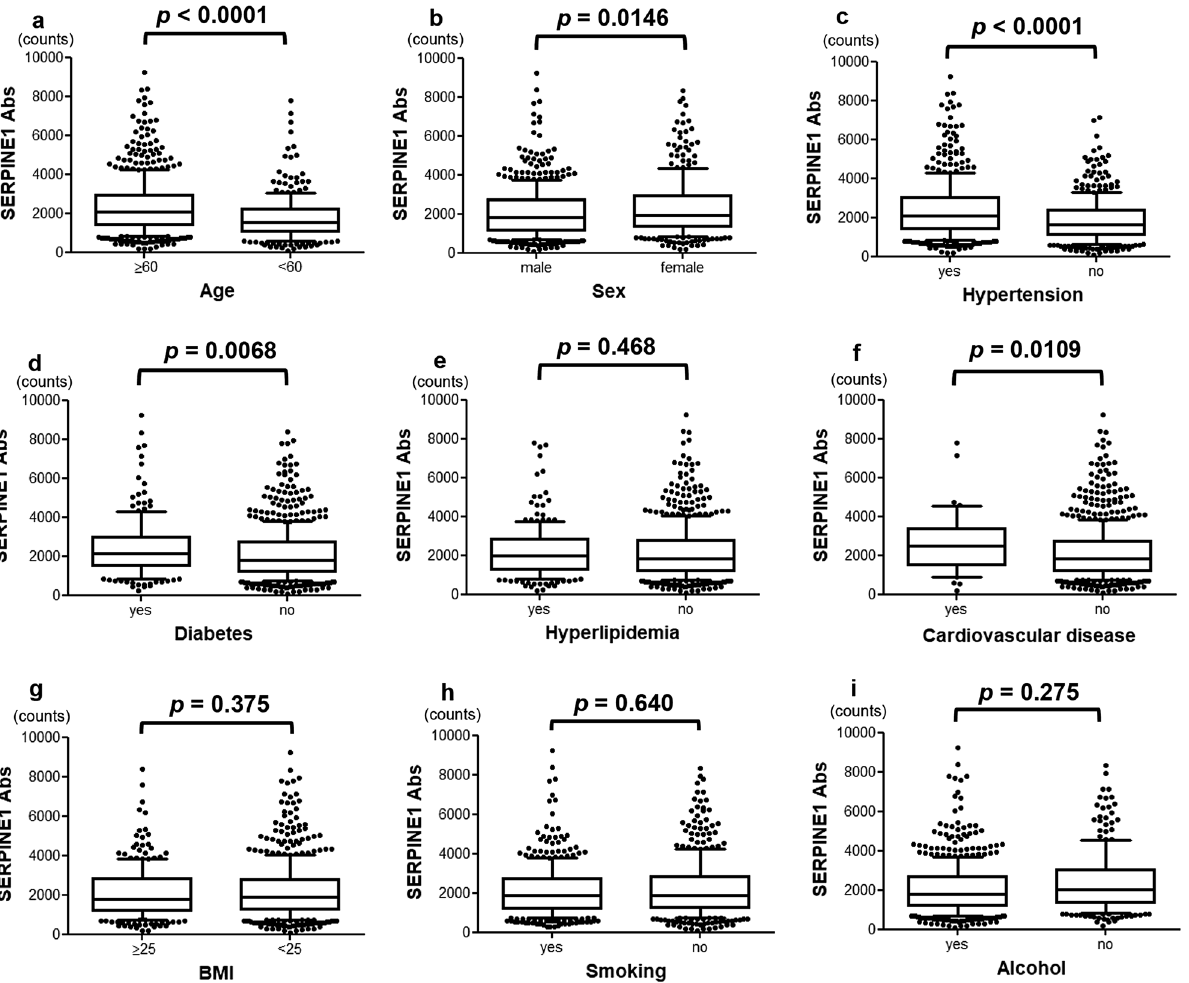
Figure 3. Association between SERPINE1 antibody levels and clinical data. The associations between SERPINE1 antibody levels and clinical parameters such as old age ( a ); sex ( b ); hypertension ( c ), diabetes ( d ), hyperlipidemia ( e ), cardiovascular disease ( f ); body mass index (BMI) ( g ); history of smoking ( h ); and alcohol consumption ( i ) were examined. The SERPINE1 antibody levels determined using AlphaLISA are shown in the box-whisker plots. The p values were calculated using the Kruskal–Wallis